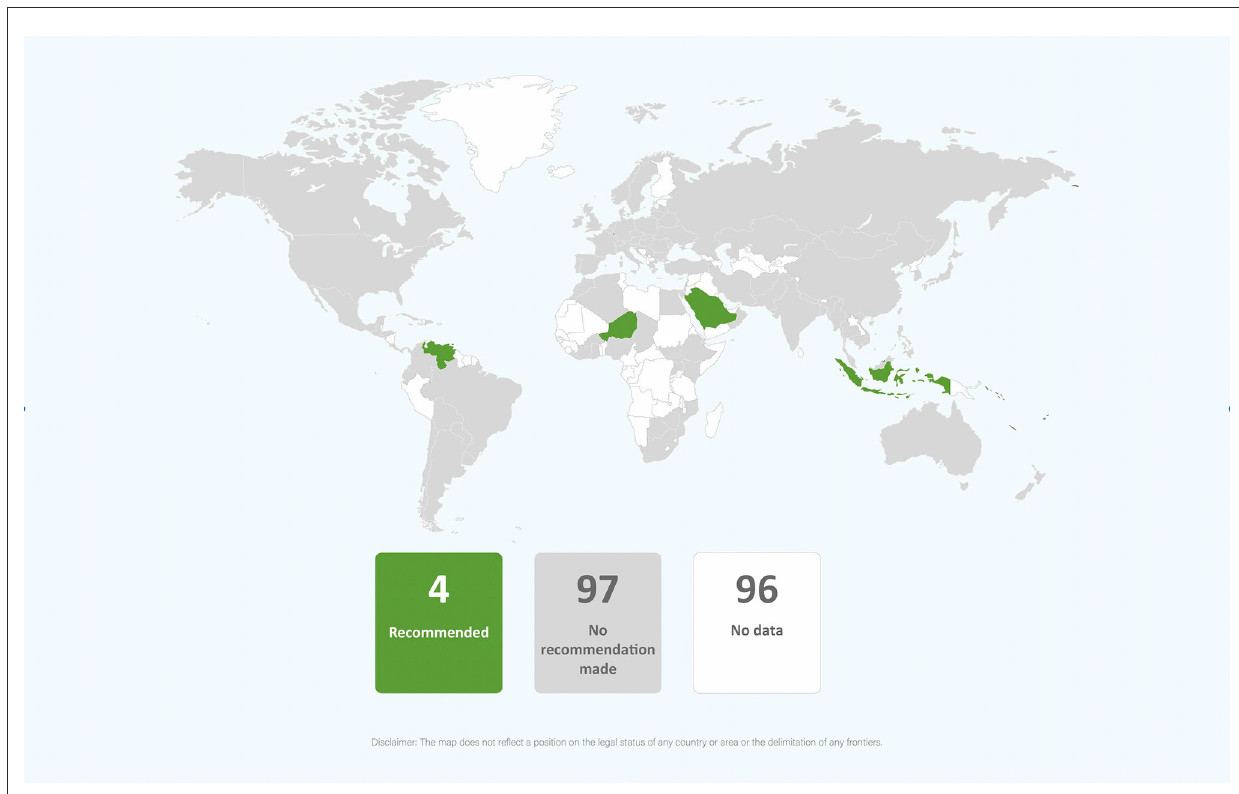
FIGURE11 Global distribution of recommendations on wet nursing infants of mothers with COVID-19 (data from 101 countries).